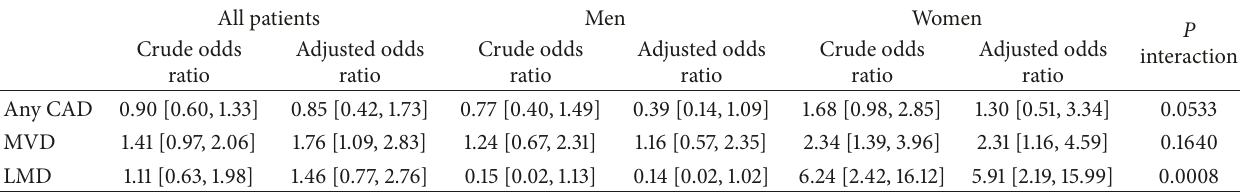
All patients Men